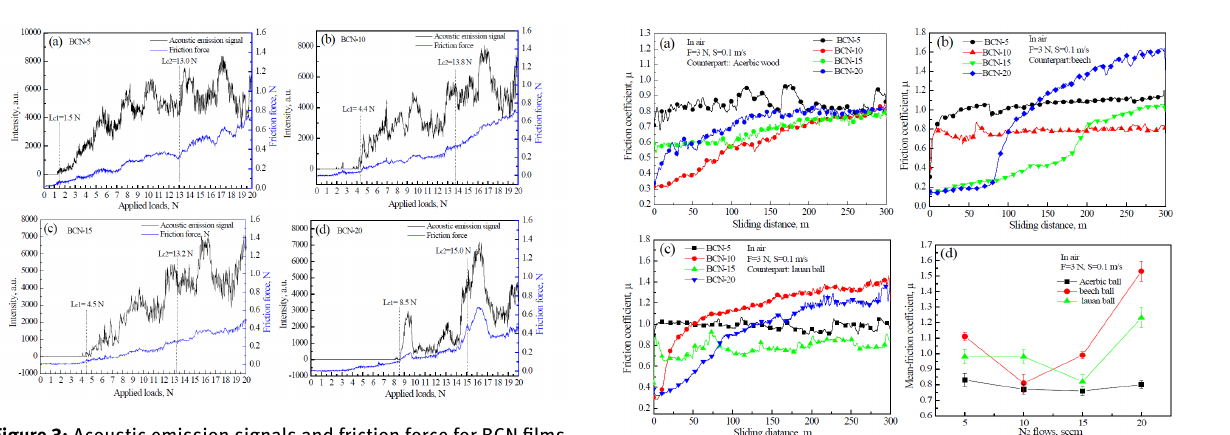
Figure 3: Acoustic emission signals and friction force for BCN films by a scratch tester.